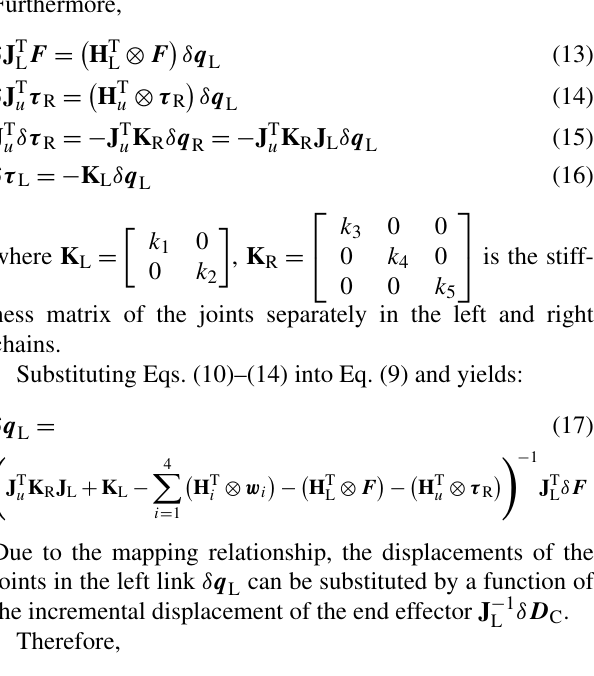
the angular changes of joints in the independent chain, in- cluding angular velocity matrices of two links, the mapping relationship between two chains and the forward